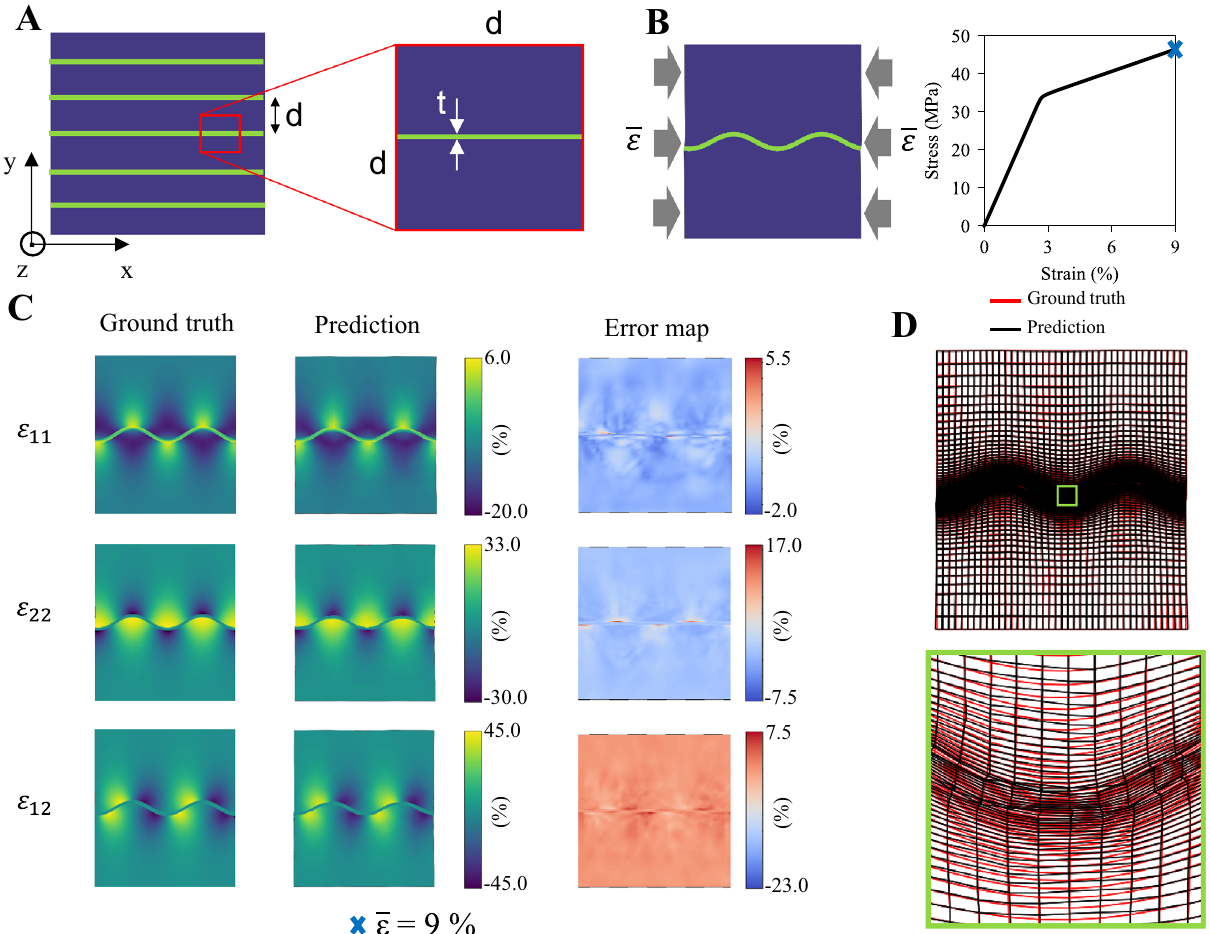
Figure 4. Predicting wrinkling of interfacial layers in stratified composites. ( A ) Schematic of a stratified composite composed of thin hard layers immersed in a soft matrix. Both phases have linear elasticity. The inset shows an arbitrary RVE of size d , corresponding to the distance between layers, and layer’s thickness t . Here, the two phases’ material properties ( E , ν ) are varied instead of the geometric parameters. ( B ) Wrinkled interface under macroscopic uniaxial compression ( ε ) together with the corresponding macroscopic stress-strain curve. The symbol identifies the post-wrinkling regime for ε =9 % . This configuration is characterized by a Young’s moduli ratio E 1 / E 0 =741 and matrix’ Poisson’s ratio ν 0 =0.13. ( C ) Comparison of the ML predicted and FE simulated strain fields in the interfacial layer shown in ( B ), randomly sampled from the test dataset, for ε =9 % , with the corresponding error maps. The stress fields are plotted over the corresponding deformed shapes, while the error maps are shown in the undeformed configuration. The strain component ε 33 is overall zero because of the plain strain hypothesis, and it is thus not here reported. ( D ) Comparison of the ML predicted and FE simulated deformed mesh of the configuration in ( B ) for ε = 9%